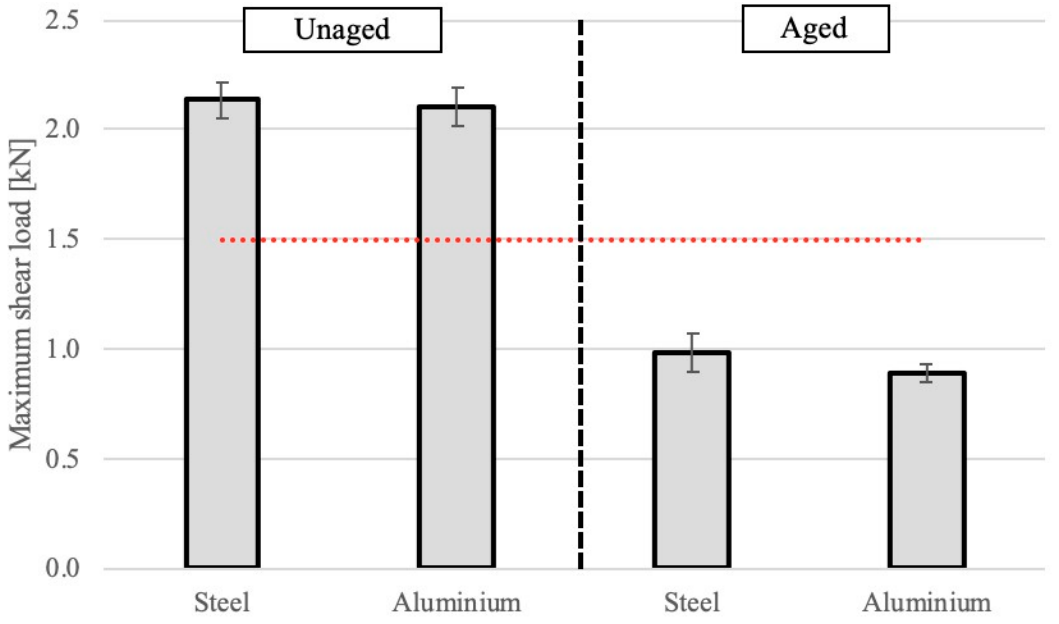
Figure 12. Maximum shear strength of RJS specimens in unaged and aged (in water) conditions. The red do tt ed line represents the threshold value for the RJS specimen’s minimum allowed joint strength (1.5 kN).